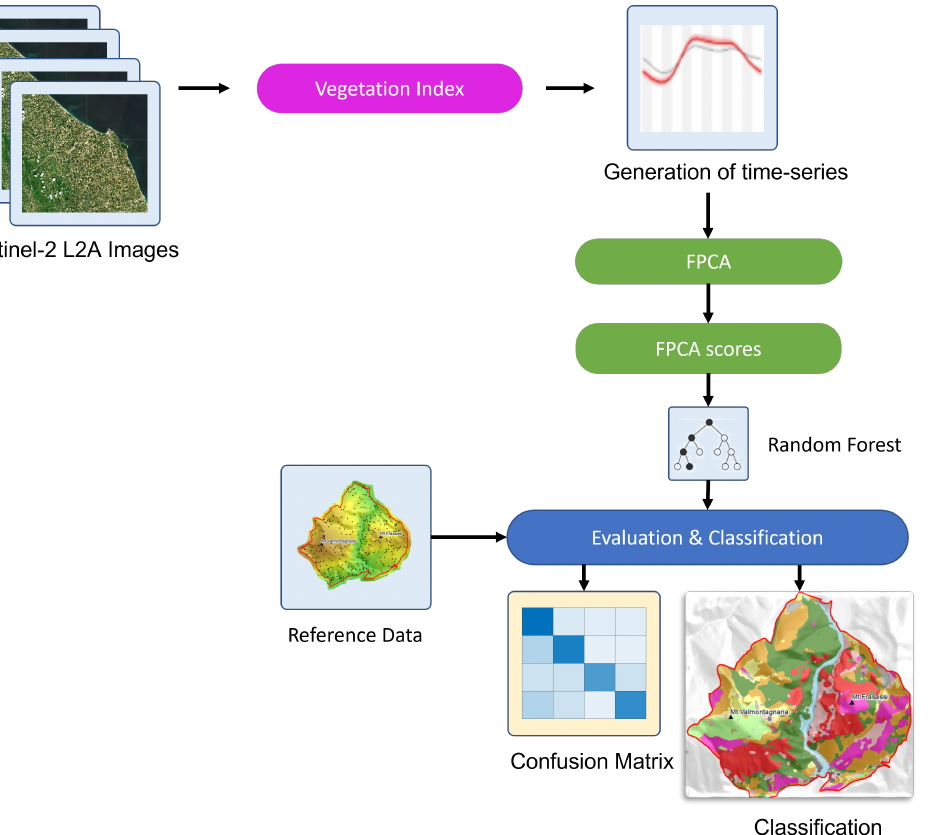
Figure 1. Supervised pipeline to derive plant associations and habitat maps from Sentinel-2 time- series using Functional Principal Component